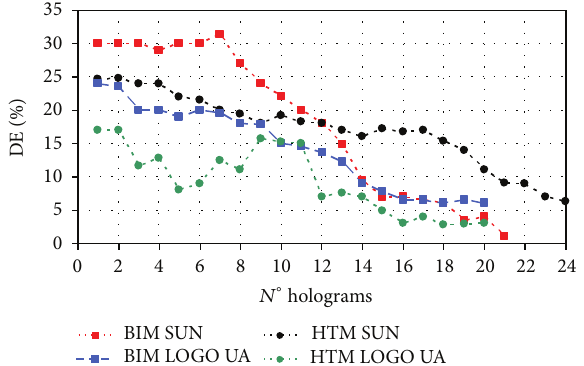
Figure 9: DE versus the hologram number for the objects of the SUN and LOGO UA for the BIM and the